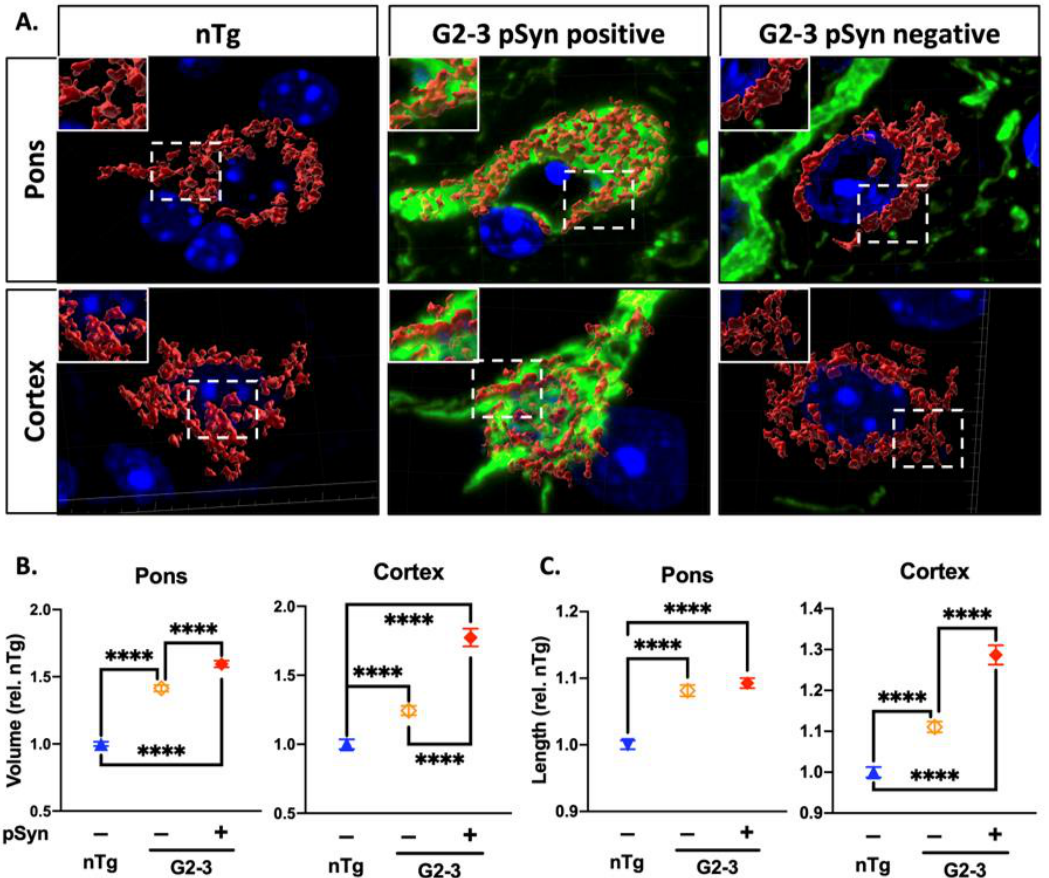
Figure 5. Increased mitochondrial volume and length is associated with αS pathology in TgA53TG2-3 Neurons. ( A ) 3D reconstruction of mitochondria (red) from z-level confocal images with DAPI (blue) and pSyn (green) fluorescence. ( B ) Morphometric quantification of mitochondrial volume and ( C ) length shows that mitochondrial volume and length are increased in pSyn-positive- and negative neurons, and that mitochondrial volume and length are differentially increased in the cortex in relation to pSyn immunoreactivity ( p < 0.0001). Displayed are mean values ± SEM (SEM/SD). Volume pons: nTg = 0.01506/0.9615, no pSyn = 0.2385/1.316, pSyn = 0.02474/1.462; volume cortex: nTg = 0.03503/1.048, no pSyn = 0.03425/1.132, pSyn = 0.06435/1.3; length pons: nTg = 0.0066/0.4189, no pSyn = 0.0084/0.4661, pSyn = 0.0075/0.4453; length cortex: nTg = 0.0127/0.3799, no pSyn = 0.01318/0.4358, pSyn = 0.02361/0.4769), calculated using ordinary one-way ANOVA ( n = 6 animals per group where at least 800 measurements were made per group). (**** p < 0.0001).